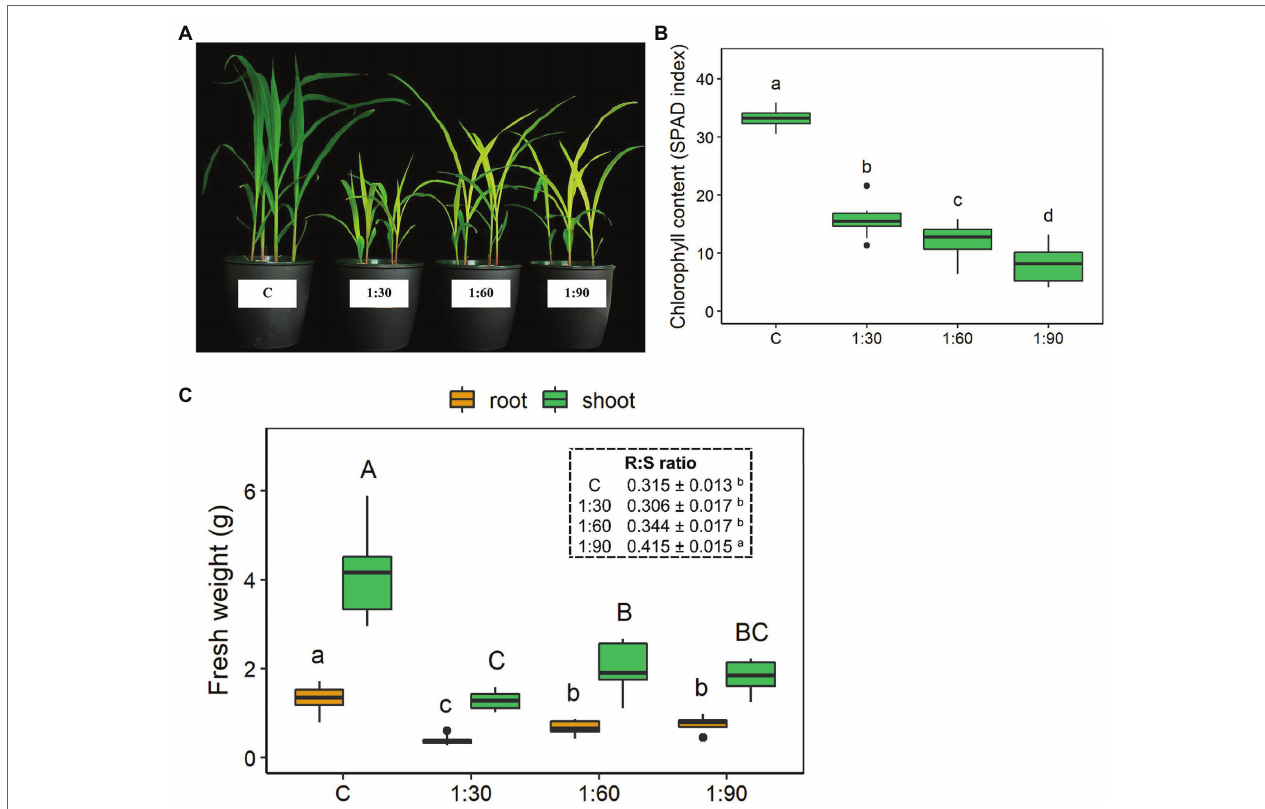
FIGURE 3 | Growth parameters of 15-day-old maize seedlings grown in the full-strength nutrient solution (C, control) and in the AHL diluted with distilled water in a ratio of 1:30, 1:60, and 1:90 (v/v): (A) representative shoots, (B) leaf chlorophyll content, and (C) shoot and root fresh weight (FW). Insert: root (R) to shoot (S) ratio. Data are presented as means ± SE ( n = 12). Statistical significance was tested by one-way ANOVA analysis with LSD post-test ( p < 0.05). Statistically significant differences among the four different growth conditions are indicated by different letters: different lower case letters indicate significant differences among the growth conditions in roots; different upper case letters indicate significant differences among the growth conditions in